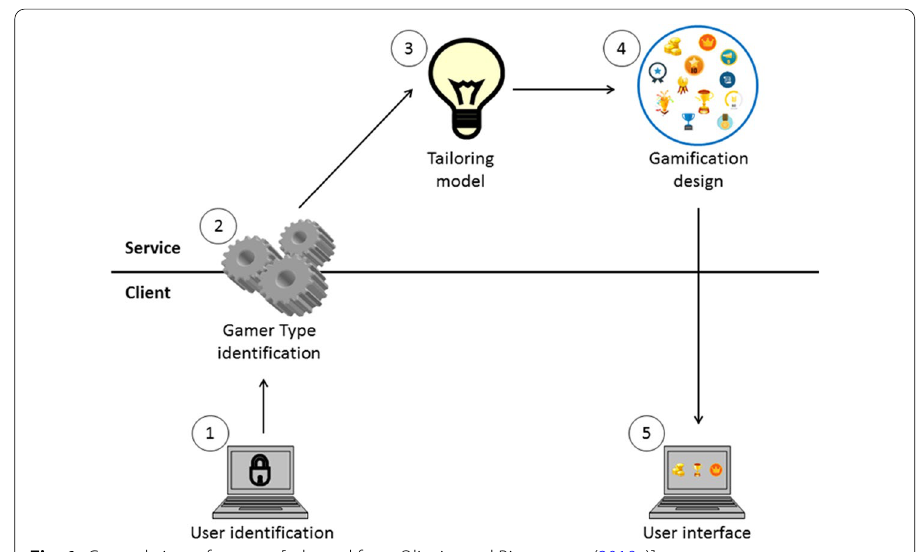
Fig. 1 General view of process [adapted from Oliveira and Bittencourt